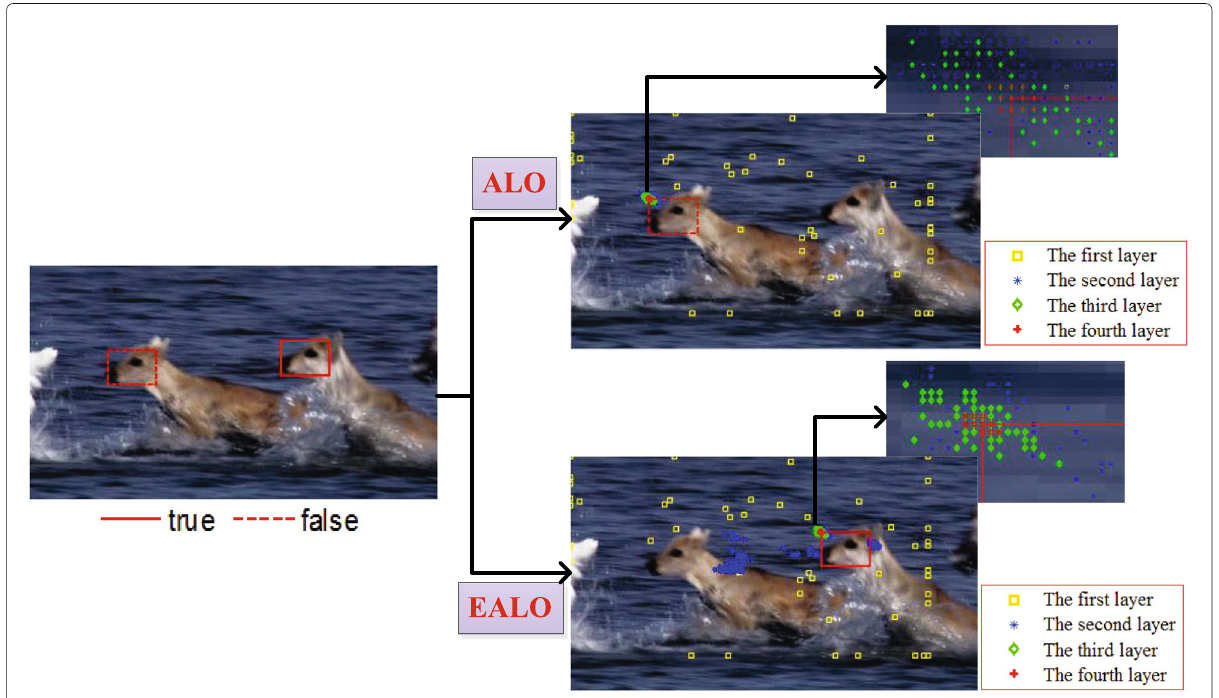
Fig. 4 The tracking result with adaptive boundary shrinking